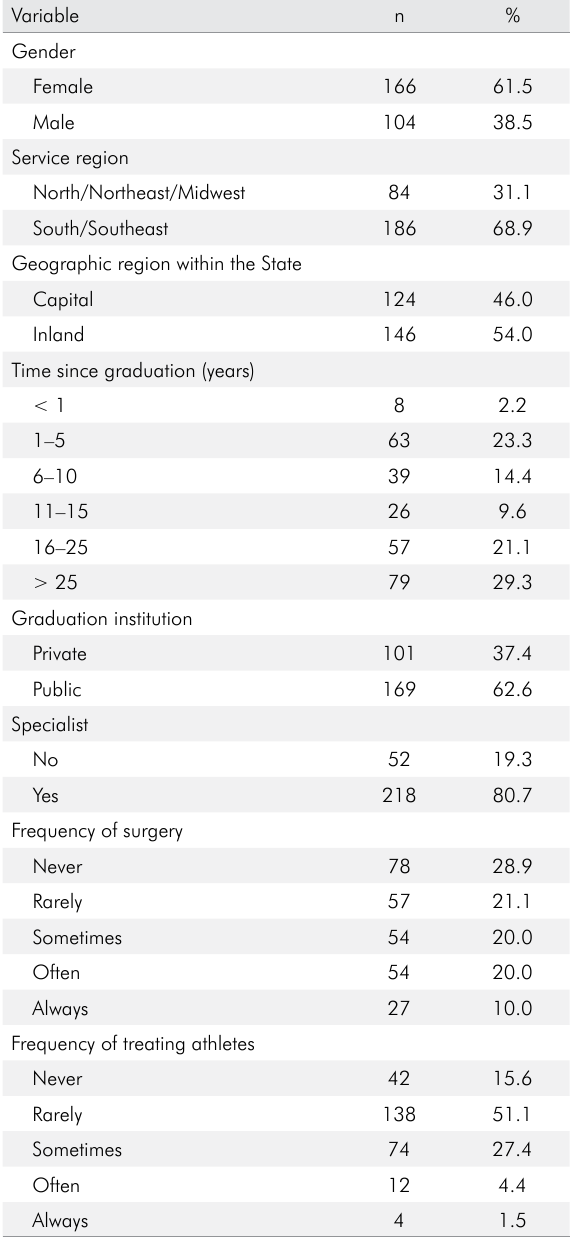
Table 3. Sociodemographic characteristics of the dentists participating in the study.